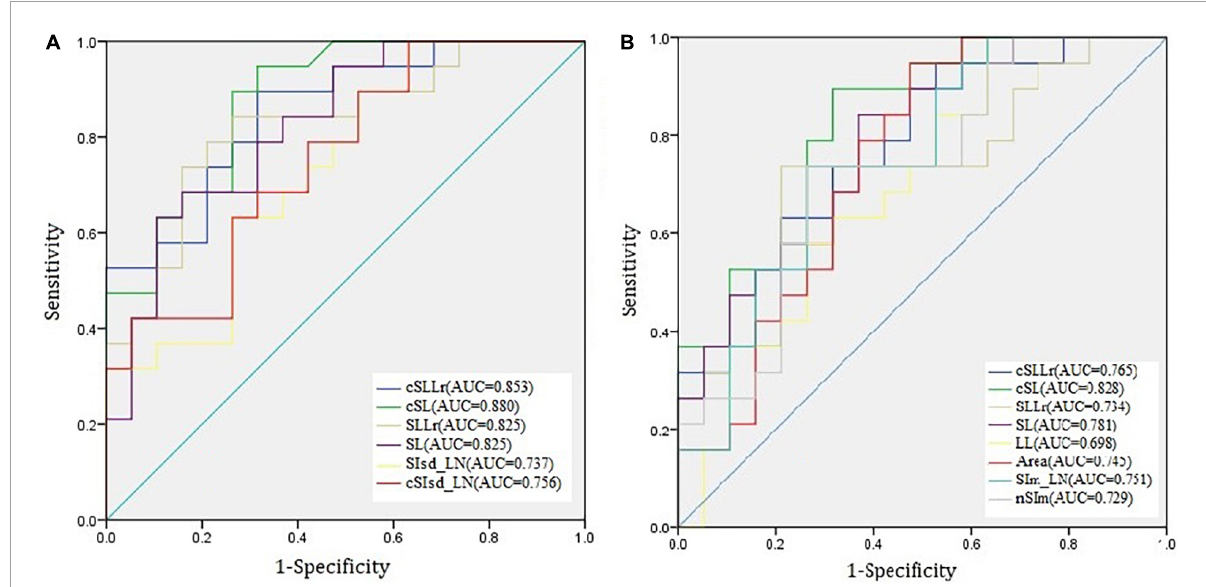
FIGURE3 The receiver operating characteristic (ROC) curves of six indexes for multiple system atrophy-parkinsonian subtype vs. Parkinson’s disease (A) and eight indexes multiple system atrophy- parkinsonian subtype vs. control group (B) .